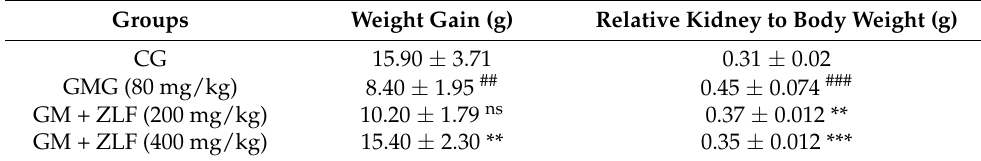
Table 2. Effect of ZLF’s on growth parameters in rats exposed to GM.